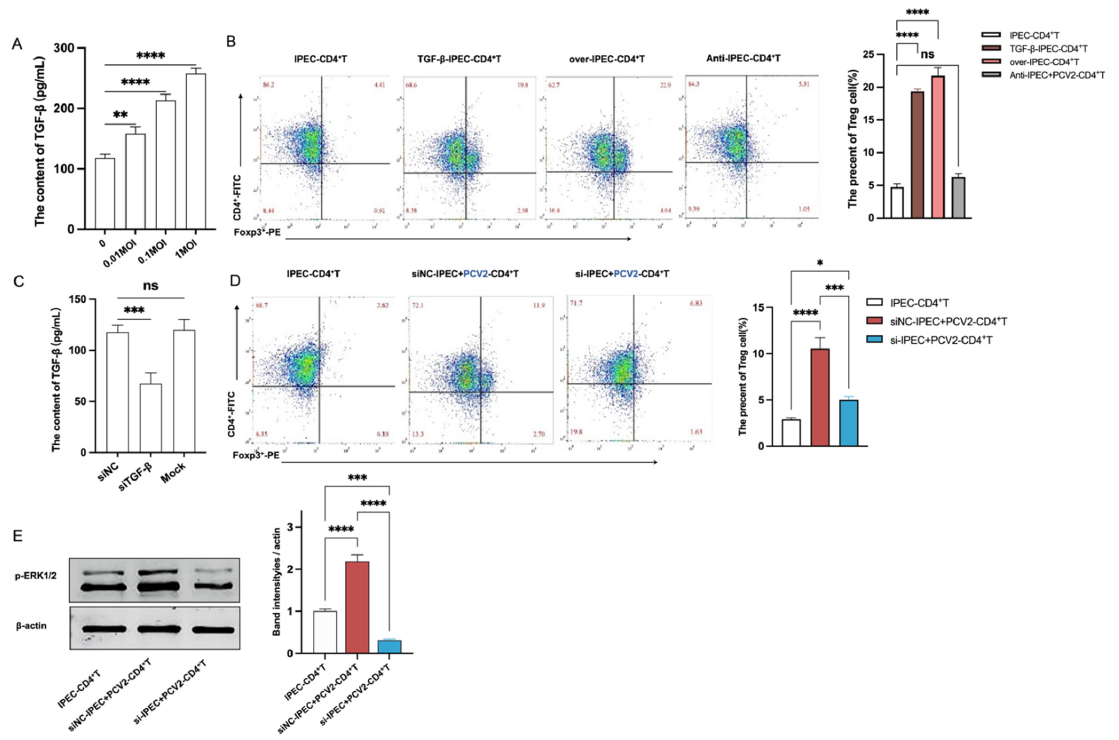
Figure 4. PCV2-infected IPEC-J2 increased the amount of Tregs in response to TGF- β from IPEC- J2. The production of TGF- β from PCV2-infected IPEC-J2 was detected by ELISA ( A ). Four groups were created: the IPEC-CD4 + T cell group, the TGF- β -IPEC+CD4 + T cell group (adding 230 pg/mL TGF- β to the IPEC-J2 culture medium), the over-IPEC+CD4 + T cell group (transfected 1 µ g of plasmid expressed TGF- β in IPEC-J2 24 h in advance) and the anti-IPEC-PCV2+CD4 + T cell group (adding 2 µ g/mL antibody against TGF- β to the IPEC culture media). After 3 days co-culture, flow cytometry was used to determine the frequencies of Treg cells ( B ). IPEC-J2 was transfected with 100 nM siTGF- β or siNC for 24 h, and the production of TGF- β from IPEC-J2 was detected by ELISA ( C ). The IPEC-J2 transfected with siTGF- β or siNC were infected with PCV2 and then co-cultured with CD4 + T cell for 3 days. The percentages of Treg cells were tested by flow cytometry ( D ). The expression of p-ERK1/2 in CD4 + T cell from ( D ) was determined by Western blotting, quantified using ImageJ and normalized to β -actin levels ( E ). All assays were performed in triplicate, with three technical repeats for each sample. **** p < 0.0001;*** p < 0.001; ** p < 0.01;* p < 0.05; ns, No Significant TGF- β gene transcription can be controlled by PI3K [27,28], c-JUN [29], NF- κ B [30,31] and p38 [30]. Here, we sought to determine whether PI3K, c-JUN, NF- κ B and p38 were involved in TGF- β transcription in IPEC-J2 following PCV2 infection. Initially, Western blotting was used to examine the effect of PCV2 on the expressions of these proteins. Fig- ure 5A demonstrates that the expression of phosphorylated p65 (a subunit of NF- κ B) was considerably increased in PCV2-infected IPEC-J2 compared with uninfected IPEC-J2, alt- hough there were no significant changes in the expressions of other proteins. Thus, we found the nuclear staining level of p65, a standard indicator of NF- κ B activation. PCV2 enhanced the nuclear translocation of p65 in IPEC-J2, indicating its positive effect on NF- κ B activation in IPEC-J2 (Figure 5B). The IPEC-J2 was treated with 20 μ M of PG490 (an NF- κ B inhibitor) to determine whether PCV2 promoted TGF- β via the activation of NF-